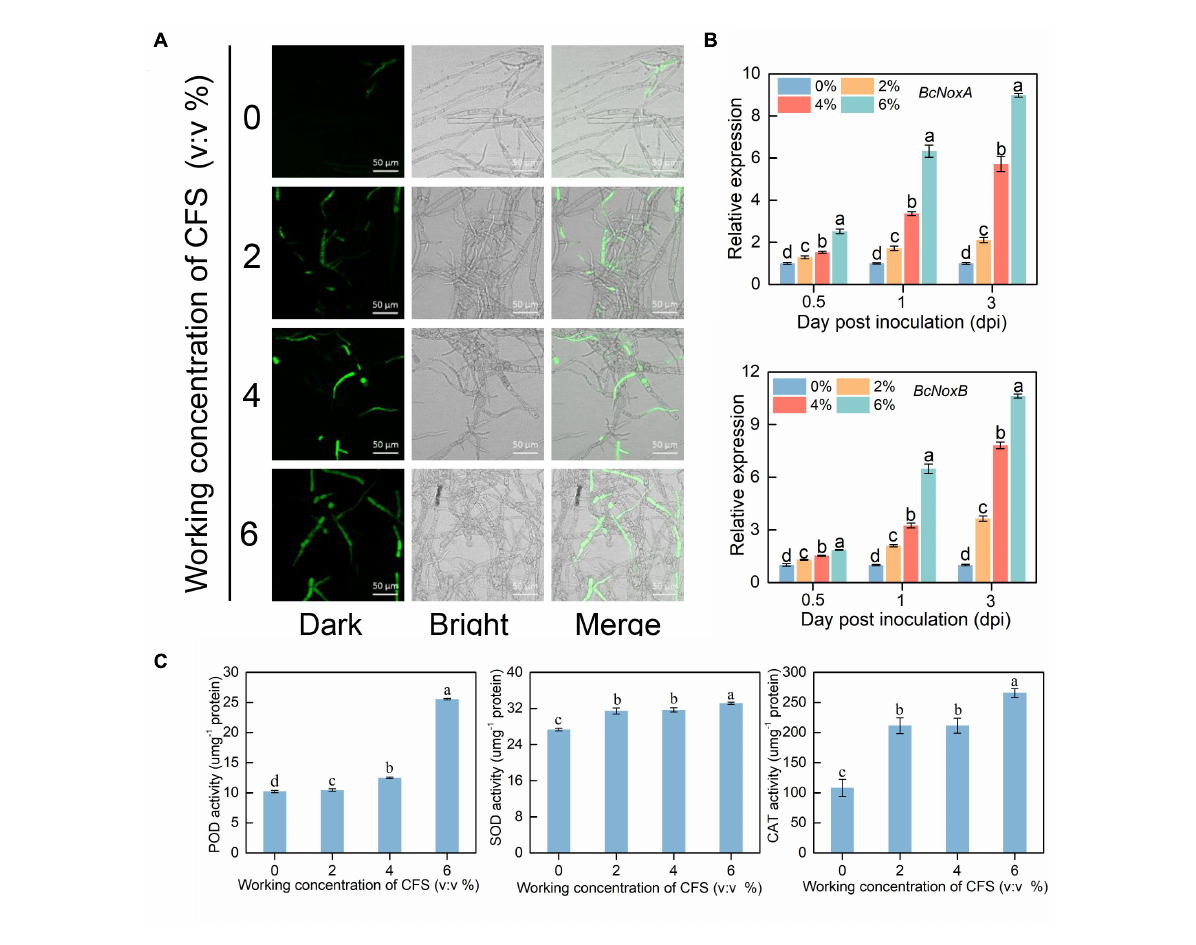
FIGURE7 Effects of cell-free supernatant (CFS) on reactive oxygen species (ROS) accumulation in Botrytis cinerea . (A) The images were recorded using confocal laser microscopy at 488 nm excitation and 520 nm emission. The hyphal cells treated with different concentrations of CFS were harvested after 24 h. Harvested hyphal cells were stained with the oxidant-sensitive probe, H 2 DCFDA, and then washed by PBS buffer for observation. (B) Gene expression levels of NoxA and NoxB at 0.5, 1 and 3 h after treatment . (C) The activities of ROS removal-related enzymes (peroxidase, superoxide dismutase and catalase) were recorded in harvested hyphal cells. Different letters above the columns indicate significant differences within each group according to Duncan’s multiple range test ( p <